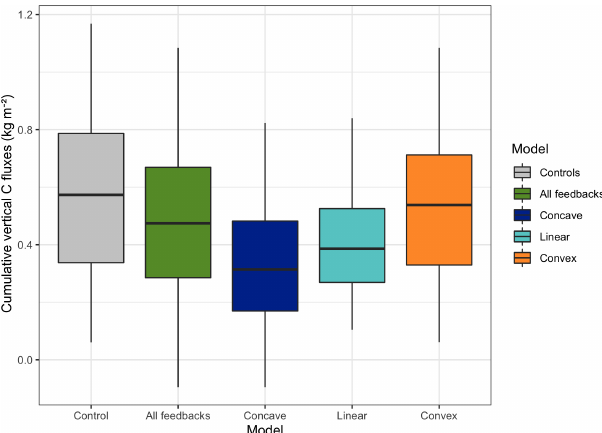
Figure 7. Comparison of the cumulative vertical C fluxes (kgCm − 2 ) between CTL (grey) and FB (colours) after 200 years of transient simulations. Positive values indicate a net flux from the atmosphere to the soil. Green, blue, light blue and orange repre- sent FB results, concave relationships, linear relationships and con- vex relationships respectively. Statistics for the concave relation- ships, linear relationships and physical relationships are performed on subsets of FB results dataset. Boxes represent the interquartile range and whiskers the 5% to 95% range of the distribution.